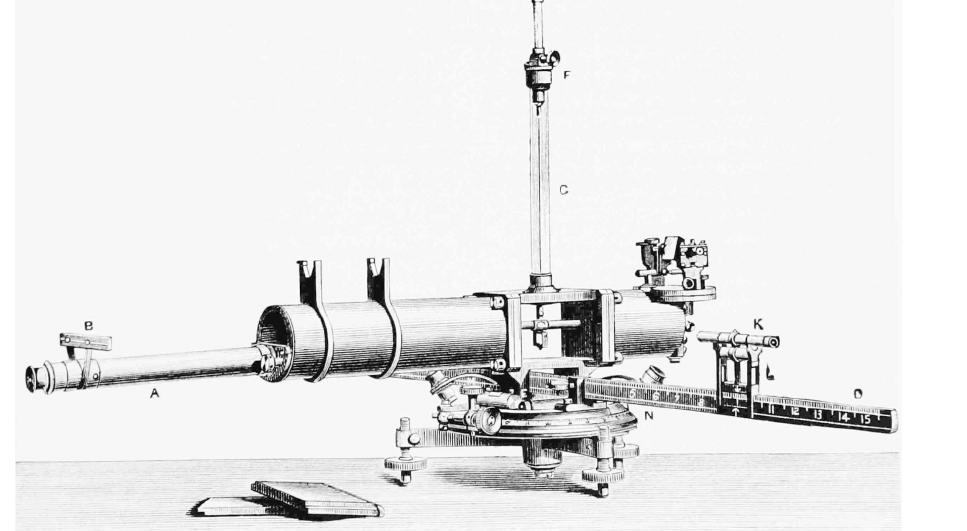
Figure 12. This is the deflection magnetometer designed and calibrated at Kew Observatory (Multhauf and Good, 1987). The magnets were kept on the scale, shown on the right, at different lengths to measure the deflection of the suspended magnet to derive H and m . This process was continued on the opposite side as well.